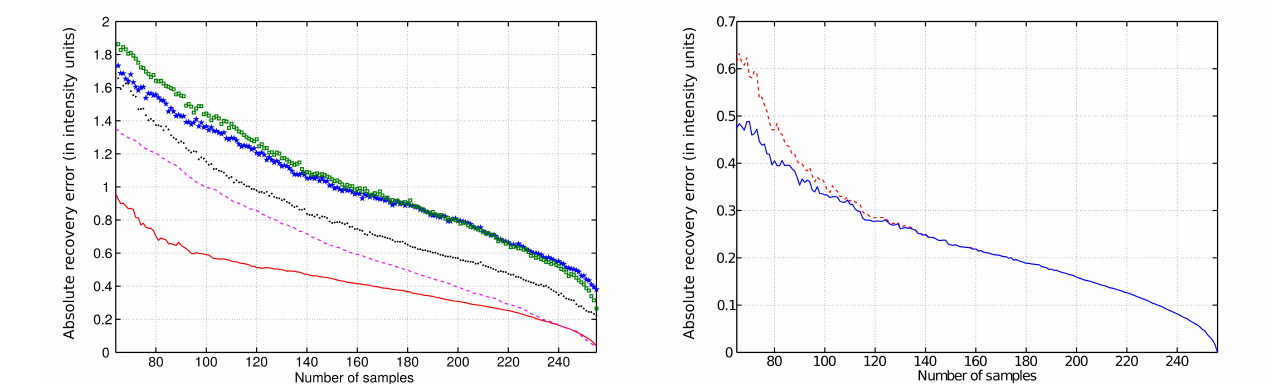
Figure 2. Quality of the reconstructions of the spectrum from Figure 1. ( Left ) The comparison of the performance of various algorithms: LPMP (solid line), iterative soft thresholding (IST) (dashed line), stage-wise orthogonal matching pursuit (StOMP) (dotted line), compressive sampling matching (COSAMP) (stared line) and orthogonal matching pursuit (OMP) (squared line). ( Right ) The performance of the masked LPMP algorithm (solid line) compared with the performance of non-masked LPMP algorithm (dashed line). The absolute recovery errors (in intensity units) are plotted vs . the number of sampling points.